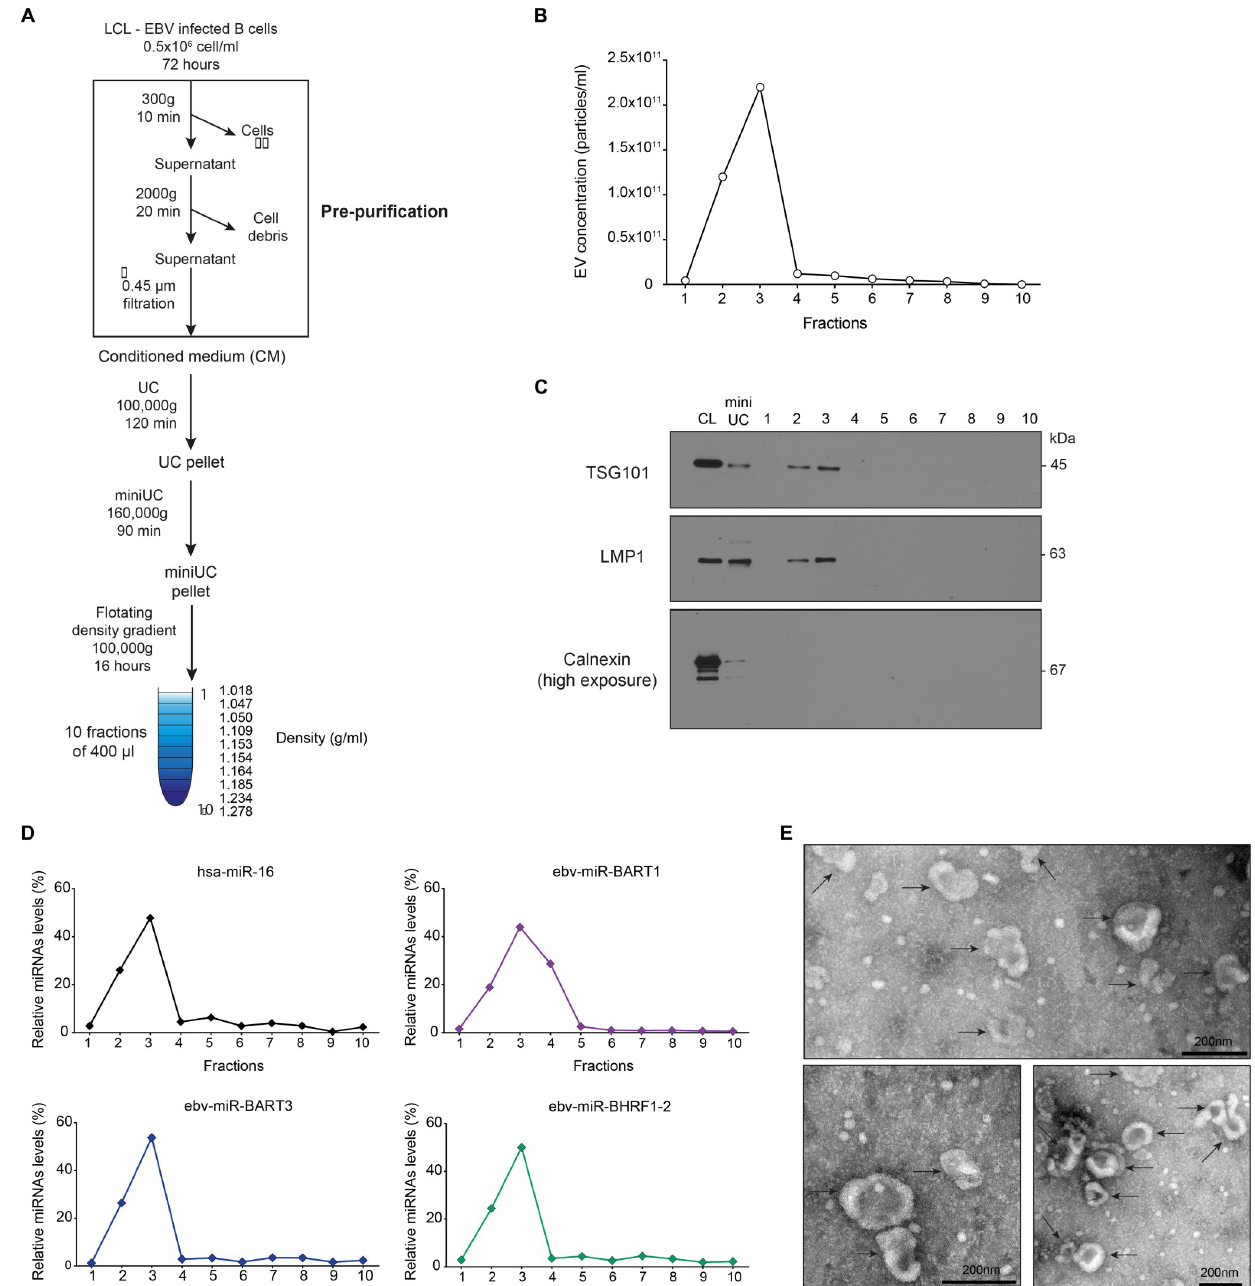
Fig 1. Isolation and characterization of extracellular vesicles from EBV-infected cells. (A) Schematic overview of our method of extracellular vesicles (EVs) enrichment and purification. EBV-infected B cells, lymphoblastoid cell lines (LCLs), were seeded at an initial density of 0.5 × 10 6 cells/ml in cell- culture medium containing 2% of EV-depleted fetal calf serum (see Materials and Methods) and processed as indicated. (B) The concentrations of EVs in the 10 fractions after iodixanol (Optiprep) floating density gradient centrifugation were measured by nanoparticle tracking analysis (NTA). One representative preparation is shown. (C) Western blot immunodetection of the EV marker protein TSG101 and the EBV protein LMP1, which are enriched in EVs, and Calnexin as a negative control in the 10 fractions. 5 μ g of the cell lysate (CL) or resuspended ‘miniUC pellet’ (mini UC) preparations as indicated in panel A were used as controls. Per density gradient fraction 10, 20, or 60 μ l were loaded onto the gels to detect LMP1, TSG101, or Calnexin, respectively. One representative preparation of three is shown. (D) Relative levels of four selected miRNAs (three viral miRNAs and a representative human miRNA) were analyzed by TaqMan RT-qPCR analysis to determine their physical density characteristics after floating density ultracentrifugation. All miRNAs are found in fractions 2–4. One representative quantification of three is shown. (E) Electron microscopic analysis of negative-stained EVs after iodixanol density gradient purification. Scale bars are 200